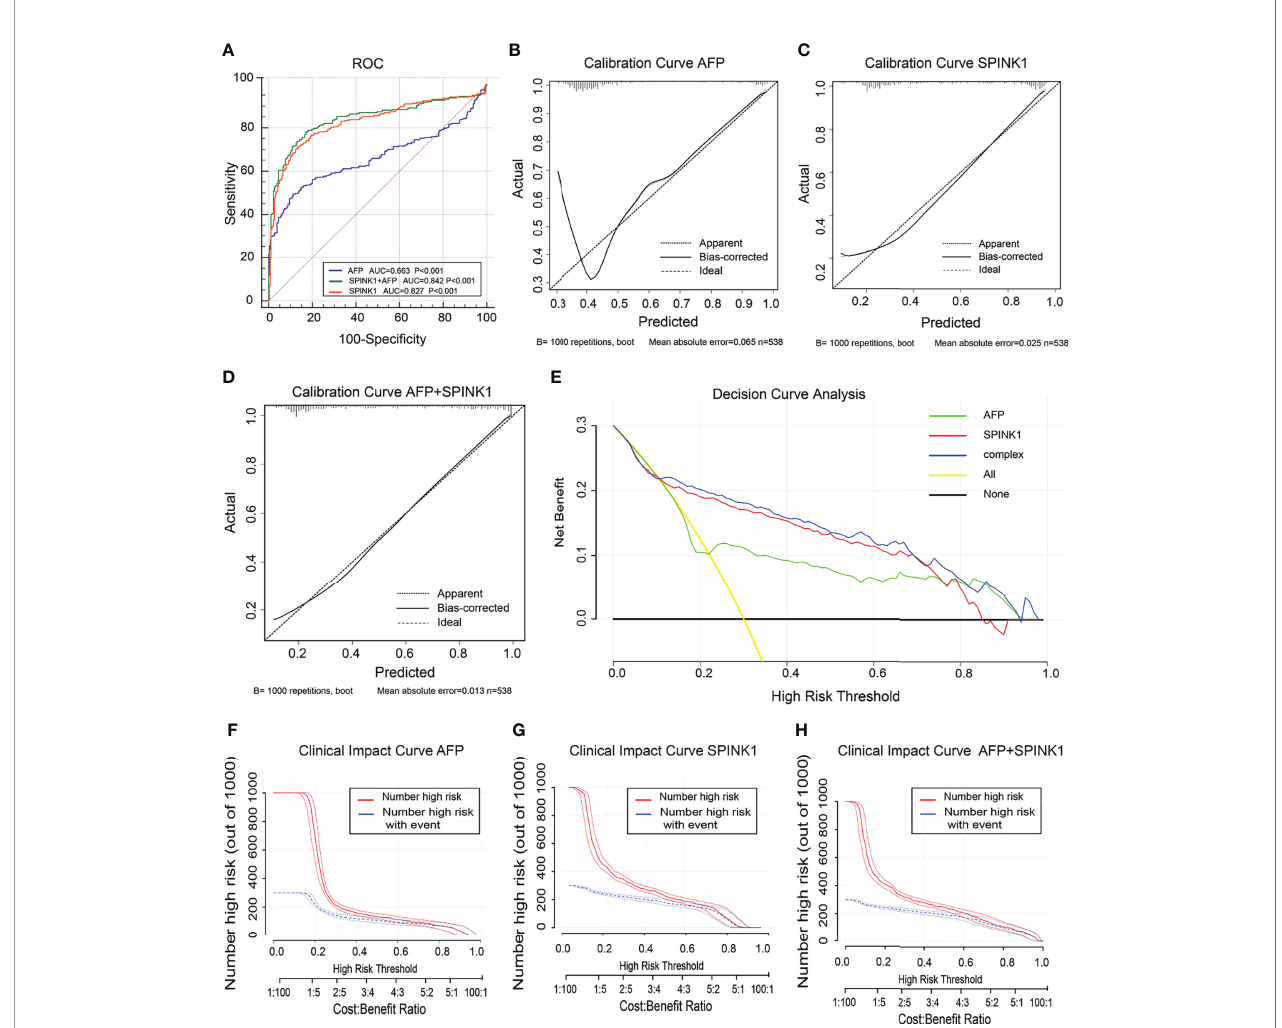
FIGURE 2 | Discrimination and calibration of hepatocellular carcinoma (HCC) prediction models through transcriptomics analyses in the training dataset. (A) Receiver operating characteristic (ROC) curves and area under the curve (AUC) in the SPINK1 , SPINK1 plus alpha-fetoprotein (AFP), and AFP models. (B – D) Calibration curves of AFP (B) , SPINK1 (C) , and SPINK1 +AFP (D) . (E) Clinical net bene fi ts in the decision curve analysis (DCA) of SPINK1 , SPINK1 +AFP, and AFP. Yellow line indicates all HCC patients; middle and horizontal black line denotes non-HCC patients. (F – H) Comparison of the clinical bene fi ts obtained from the clinical impact curve (CIC) analysis of each detection